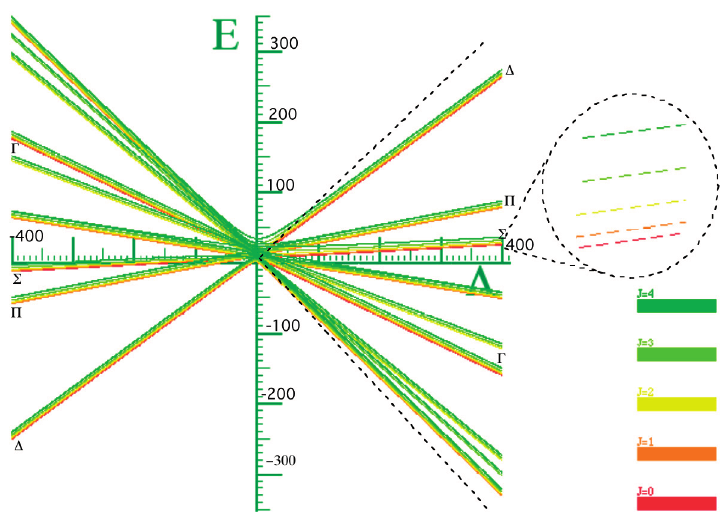
Figure 4. Energy vs. coupling of X 2 molecule for J = 1, n =